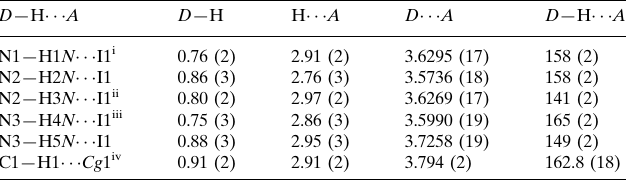
Hydrogen-bond geometry (A˚ , (cid:3)